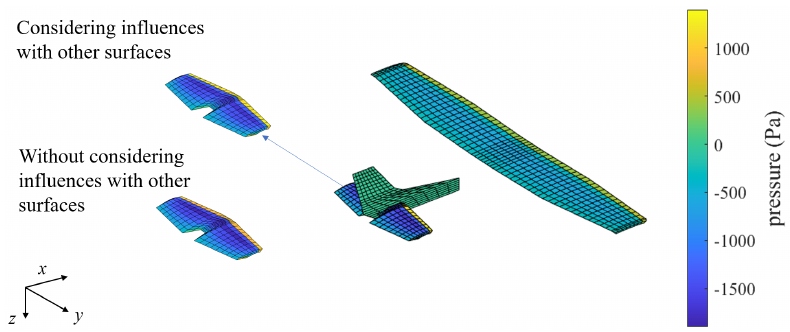
Figure 13. Effect of other lifting surfaces on the horizontal